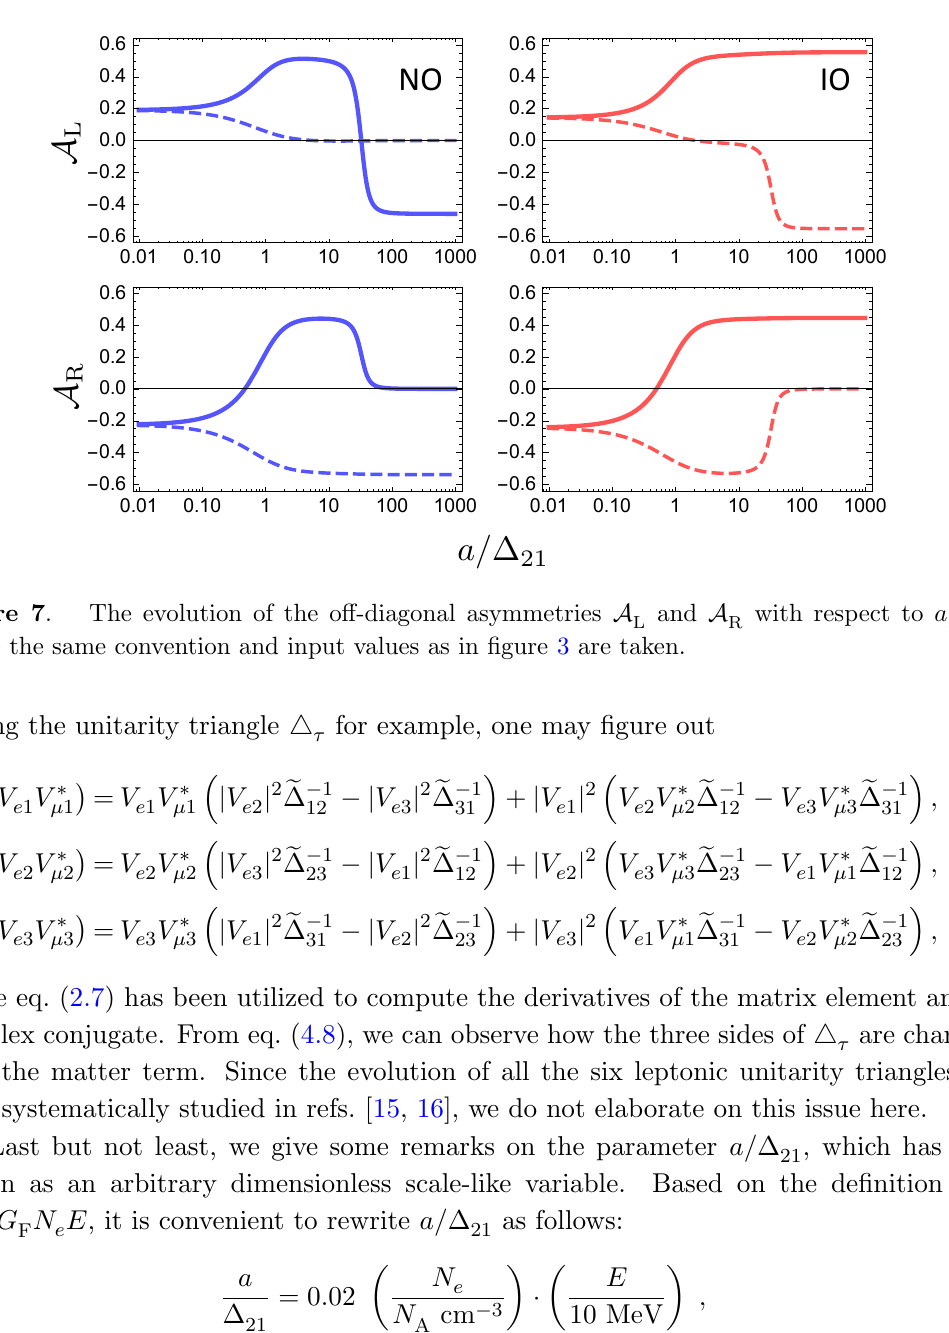
illustration: JUNO reactor antineutrinos at (4 MeV ; 1 : 5 N (10 MeV ; 10 2 N = cm 3 ) [1] and DUNE with accelerator neutrinos at ( GeV ; 1 : 5 N A